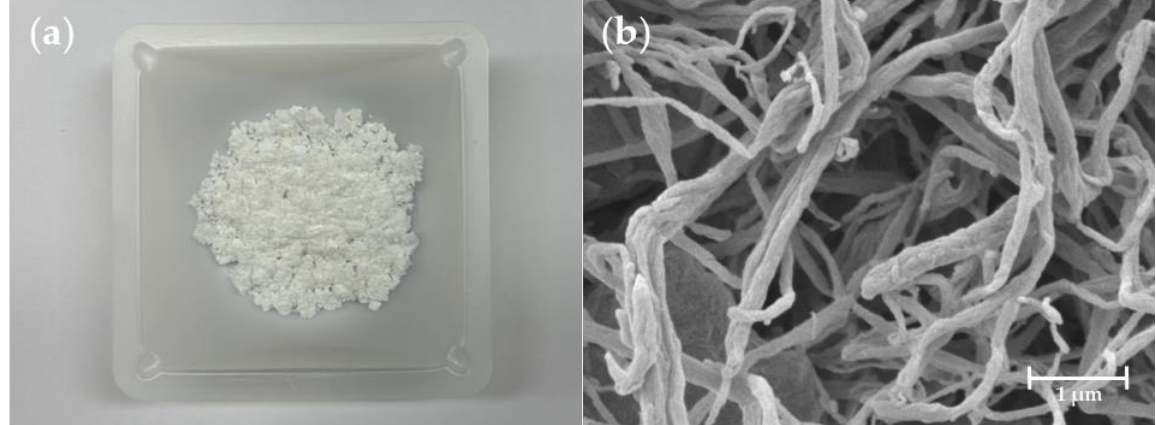
Figure 2. ( a ) CNF powder, and ( b ) FE-SEM image of CNF